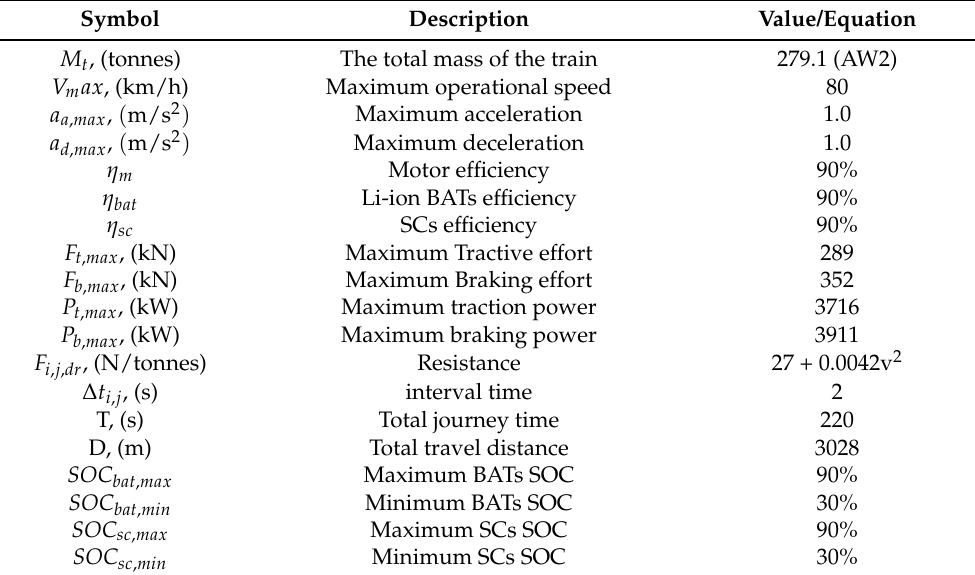
Figure 4. The part of route structure in Guangzhou metro line 7 from Google map. Table 3. Key parameters in Guangzhou metro line 7 for a typical railway vehicle with on-board HESDs